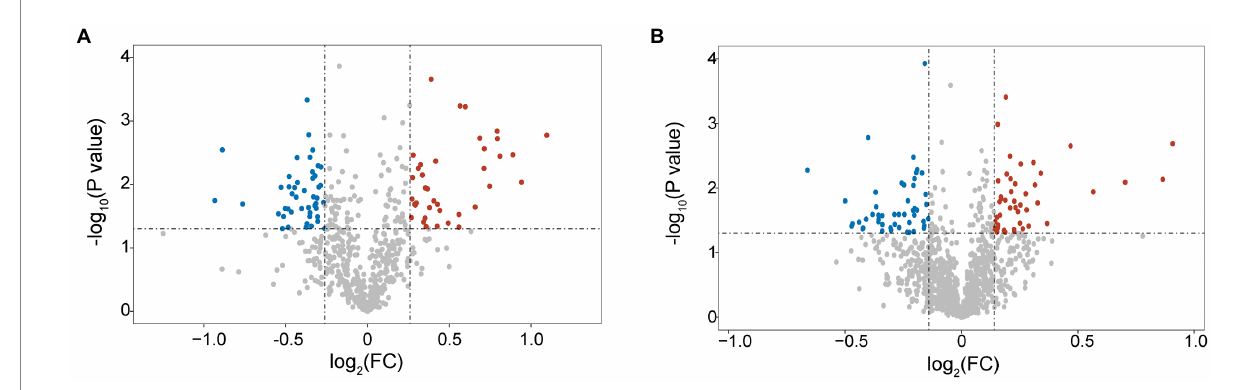
FIGURE 1 Volcano plot of differentially expressed proteins (DEPs) in B. pumilus (B18 vs. B40) (A) and K. vulgare (K18 vs. K40) (B) . Each point represents a protein, and the red and blue areas represent upregulated and downregulated proteins (in B. pumilus , FC ≥ 1.2 or FC ≤ 0.83 and p < 0.05; in K. vulgare FC ≥ 1.1 or FC ≤ 0.91 and p < 0.05), respectively.